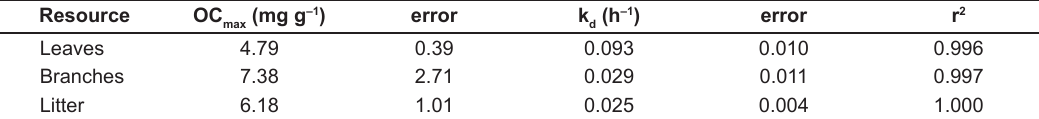
Table 2. Kinetics model parameterization from aerobic mineralization of leaves, branches and litter. Resource